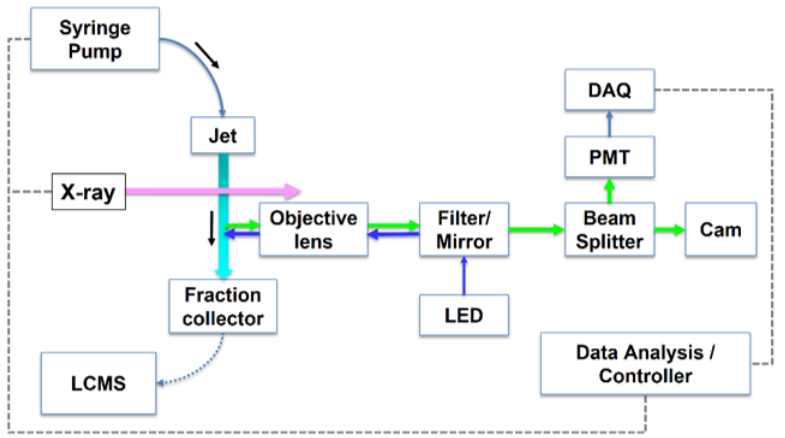
Figure 6. Conceptual diagram of inline dosimetry monitoring in XFMS experiments. Excitation light impinges on a flowing sample (capillary or jet delivery) immediately after X-ray exposure and before sample enters the fraction collector. The resulting fluorescence is collected along the same light path and analyzed to determine appropriate X-ray exposure values. Reproduced from [82], Figure 1A, used with permission.